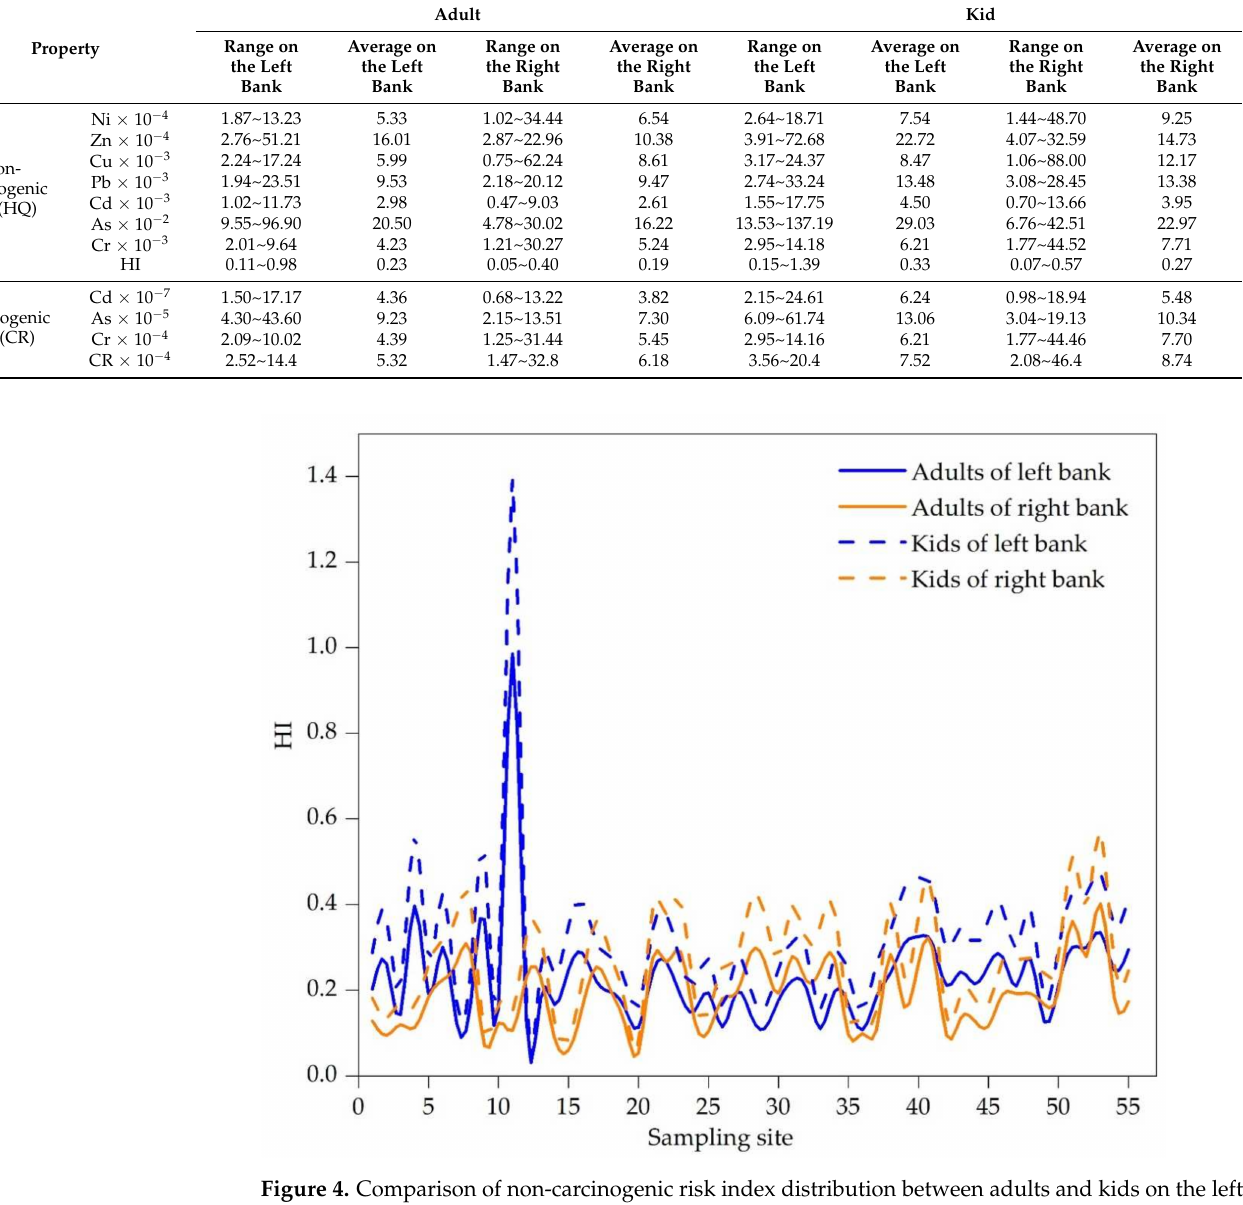
Figure 4. Comparison of non-carcinogenic risk index distribution between adults and kids on the left bank and the right